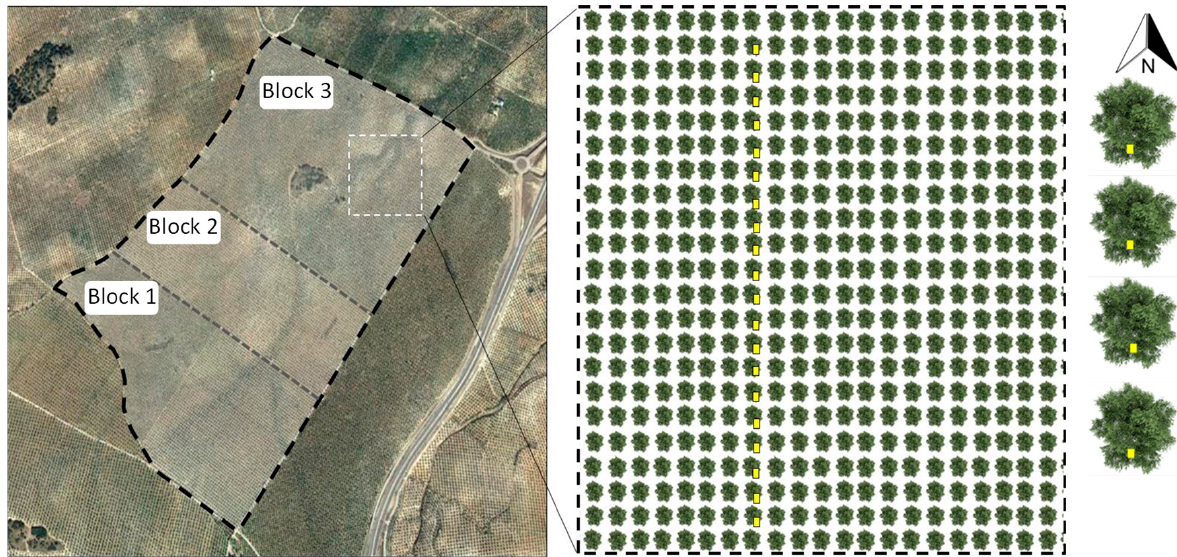
Figure 2. Aerial view of the VC olive grove, with broken lines indicating the three blocks into which it has been divided. The enlarged box shows the linear arrangement of the chromatic traps along a line of 20 olive trees. On the right, detail of the orientation of the traps. Source: Own elaboration using the Google Earth Pro geographic information system.